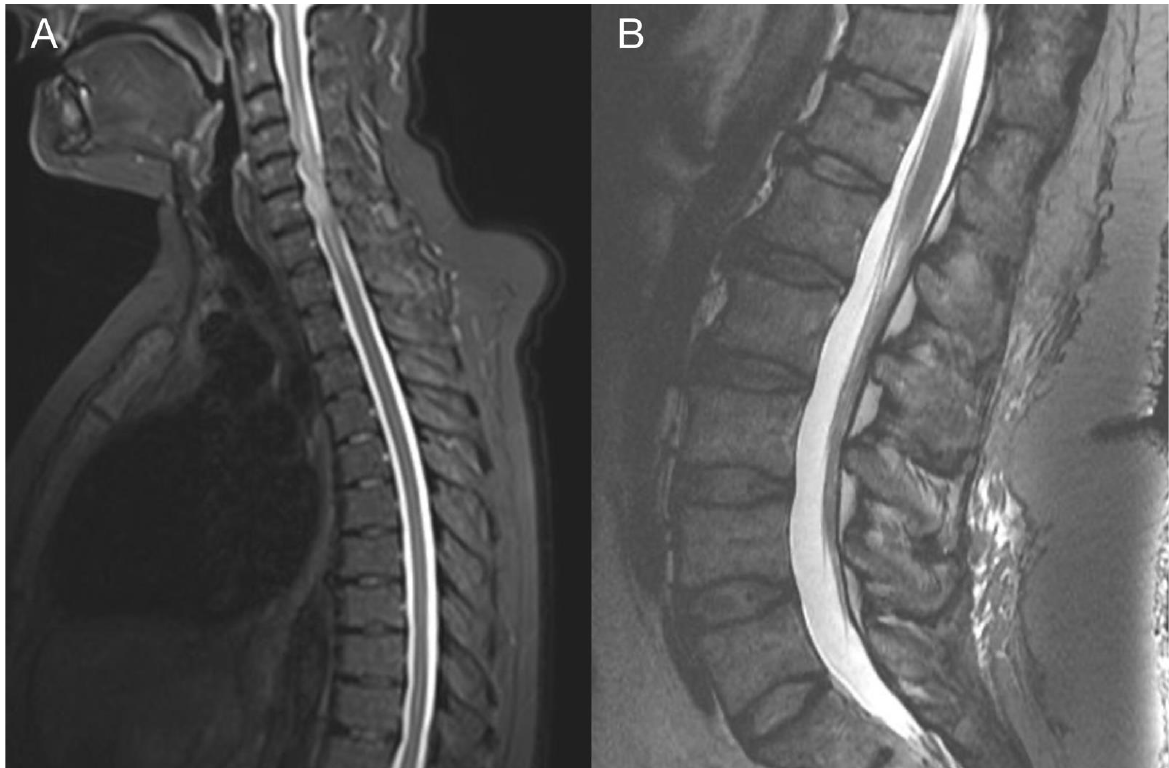
Figure 6. Imaging of the spinal metastasis. Five-month postoperative cervical spine MRI (postcontrast T1 weighted images) showing intradural expansion (arrow) at the C6 level intimately related to the spinal cord with spinal cord compression ( A ). Axial section showing intradural expansion (arrow) partially encircling the spinal cord and spreading into the neural foramen ( B ).